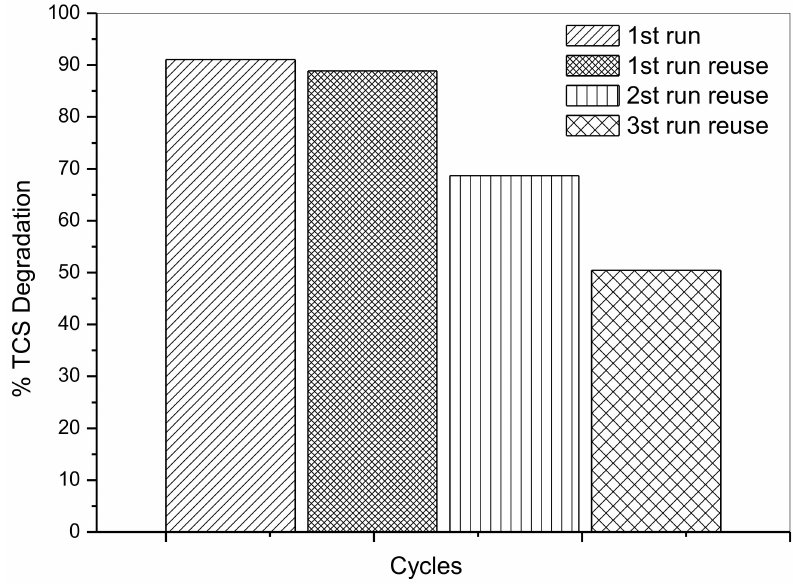
Figure 8. Photocatalytic reuse cycle (1.5%Fe/Nb 2 O 5 calcined at 873 K).